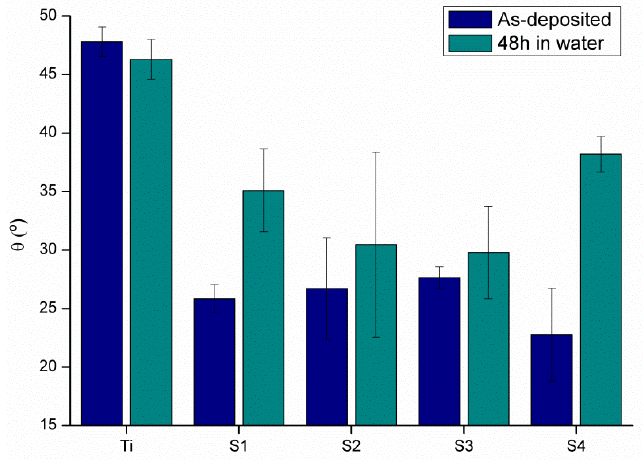
Figure 5. Water contact angle of the coatings as-deposited and after 48 h of immersion in deion- ized water.